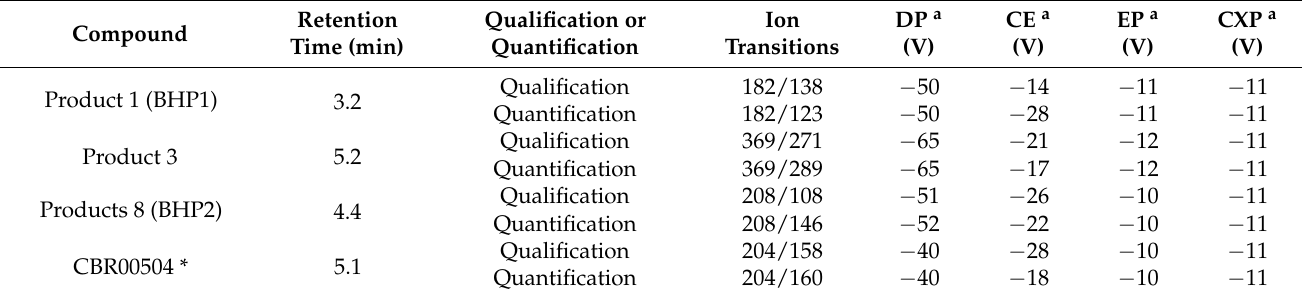
a DP: declustering potential; CE: collision energy; EP: entrance potential; CXP: collision cell exit potential. * internal standard. 3.2. Structural Characterization of BHP1 and BHP2 The ESI − mass spectrum of BHP1 exhibited the deprotonated molecular ion at m / z 182 and a major daughter ion at m / z 138, indicating that the product contains a carboxyl group. Based on its 1 H NMR and heteronuclear multiple-quantum correlation (HMQC) spectra (Figures S1 and S2), and a comparison with the NMR data in the literature [34,35], BHP1 was characterized as hematinic acid (Scheme 2), a known compound.